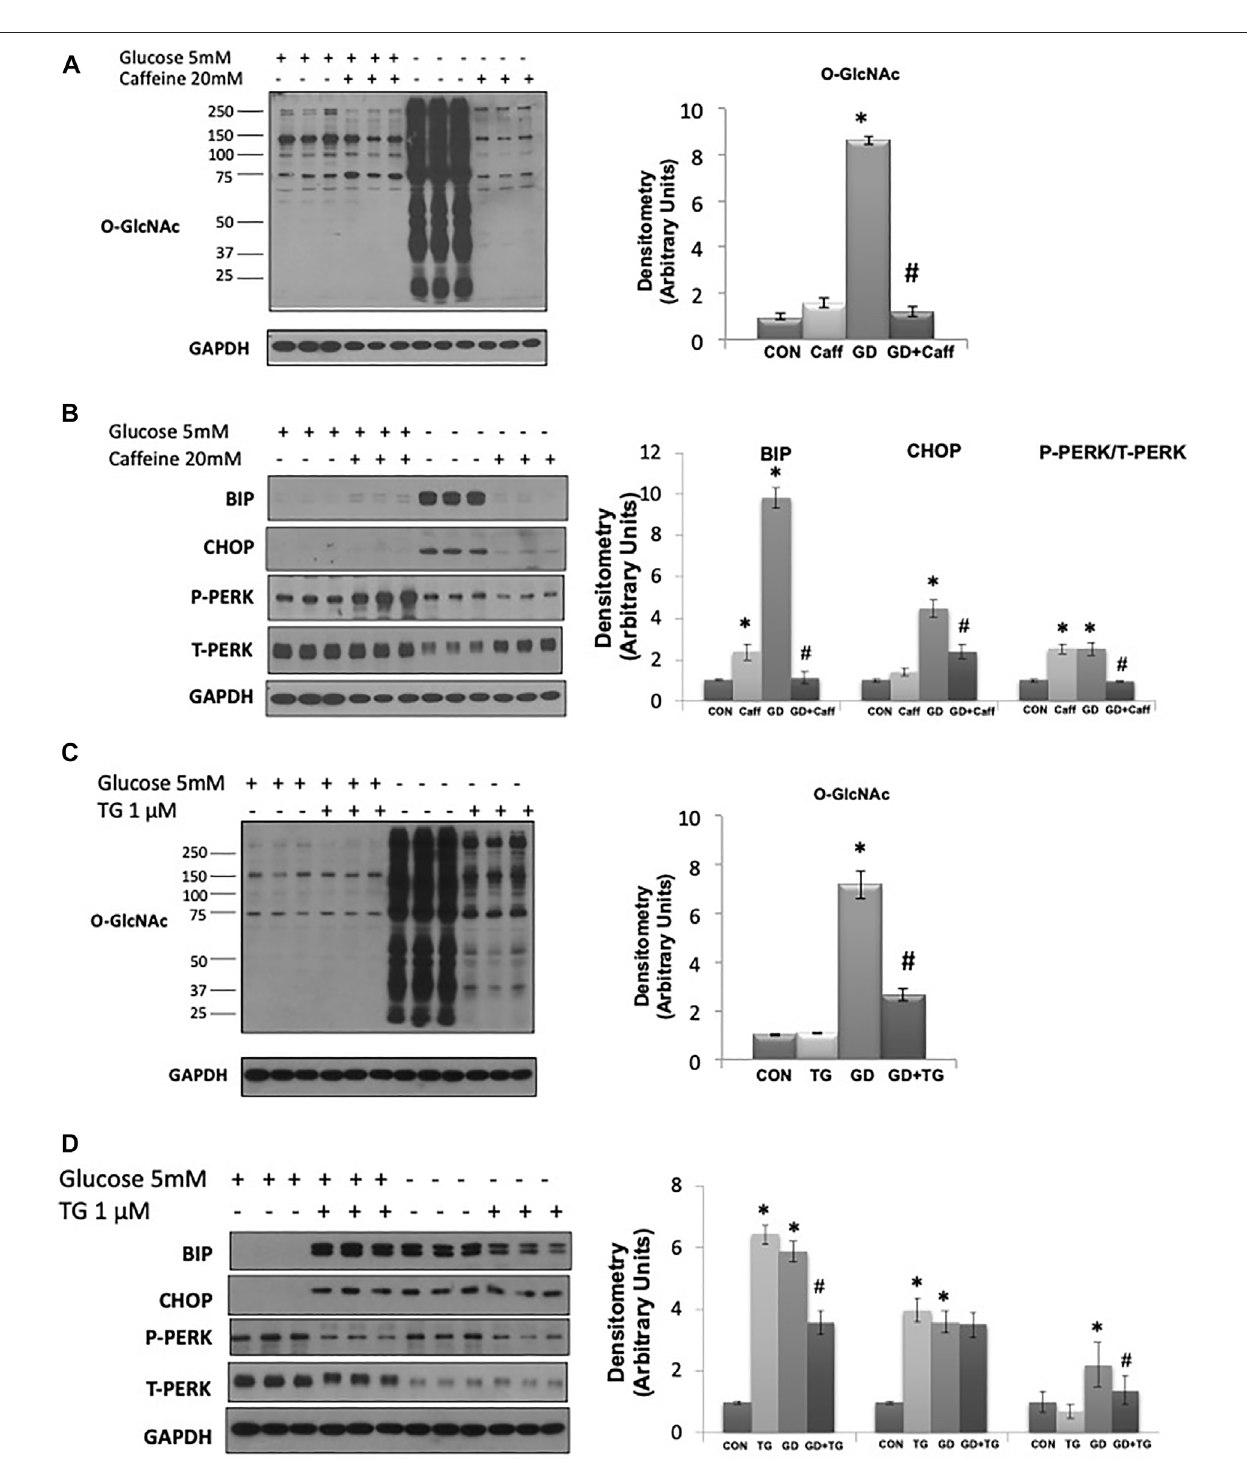
FIGURE 3 | The effects of caffeine and thapsigargin (TG) on the glucose deprivation induced increase in O-GlcNAc and ER Stress in AC16 cells: (A) Left panel: O-GlcNAc immunoblots with and without glucose in the presence or absence of caffeine (5 mM). Right panel: Quanti fi cation of immunoblots normalized to GAPDH. (B) Leftpanel:BiP,CHOP,phospho-(P)andtotal(T)PERKimmunoblots,withandwithoutglucoseinthepresenceorabsenceofcaffeine(5 mM).Rightpanel:Quanti fi cation of immunoblots normalized to GAPDH. (C) Left panel: O-GlcNAc immunoblots with and without glucose in the presence or absence of thapsigargin (1 µM). Right panel Quanti fi cation of immunoblots normalized to GAPDH. (D) Left panel: BiP, CHOP, phospho- (P) and total (T) PERK immunoblots, with and without glucose in the presence of thapsigargin (1 µM). Right panel: Quanti fi cation of immunoblots normalized to GAPDH. All data are expressed as mean ± S.E.M. of 3 – 6 independent experiments. * p < 0.05 vs. Control (Con) group; # p < 0.05 vs. glucose deprivation (GD) group.